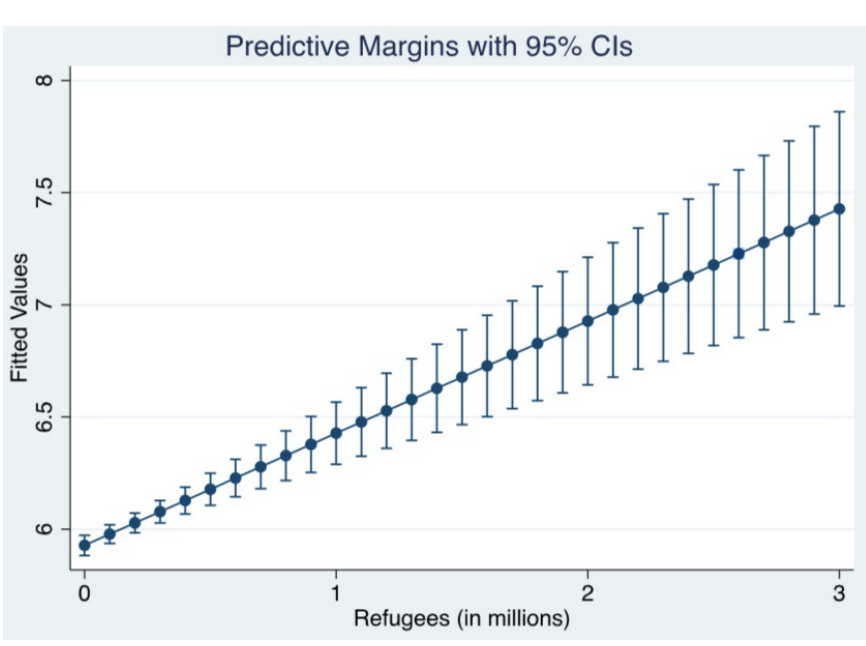
Figure 1. Refugees and violent group